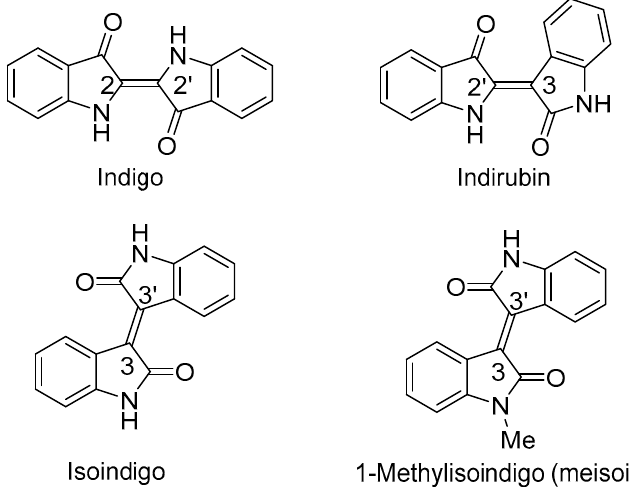
Figure 1. Structures of bisindoles: indigo, indirubin, isoindigo, and N -methylisoindigo (meisoindigo).